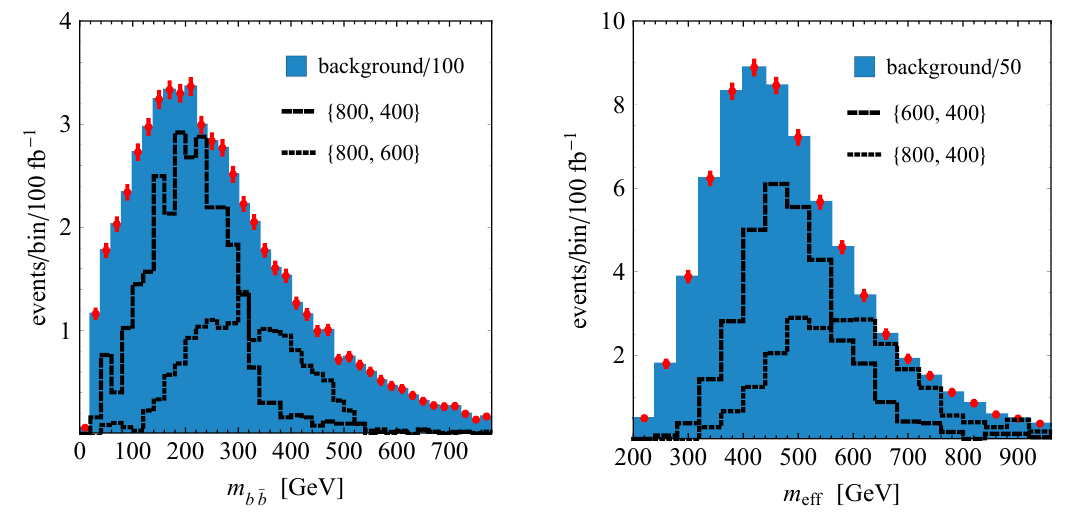
Figure 8 . Left: the coloured histogram depicts the background m distribution scaled down by b (cid:22) b a factor of 100. The predictions in the type-II 2HDM corresponding to M H = 800 GeV, M A = M = 400 GeV ( M H = 800 GeV, M A = M = 600 GeV), c (cid:12) (cid:0) (cid:11) = 0 and t (cid:12) = 1 are superimposed H (cid:6) H (cid:6) as dashed (dotted) black lines. Right: the coloured histogram corresponds to the m e(cid:11) distribution of the background reduced by a factor of 50. The signal prediction in the type-II 2HDM has been obtained for M H = 600 GeV, M A = M = 400 GeV ( M H = 800 GeV, M A = M = 400 GeV), H (cid:6) H (cid:6) c (cid:12) (cid:0) (cid:11) = 0 and t (cid:12) = 1 and is represented by a dashed (dotted) black line. All predictions are obtained p at s = 14 TeV and take into account the selection requirements that are detailed in the text. The shown error bars represent the statistical uncertainties of the entire SM